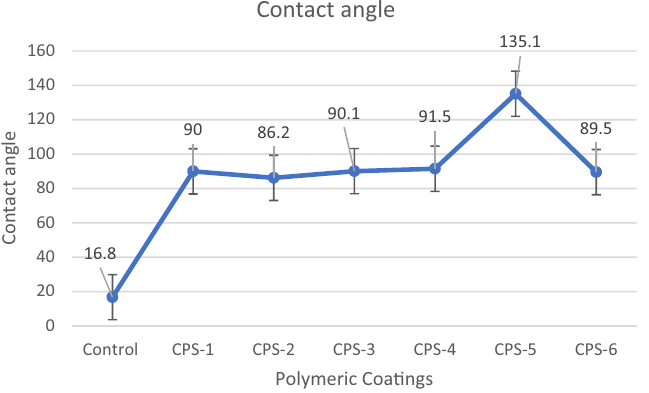
Figure 9. Graphical representation of contact angle.